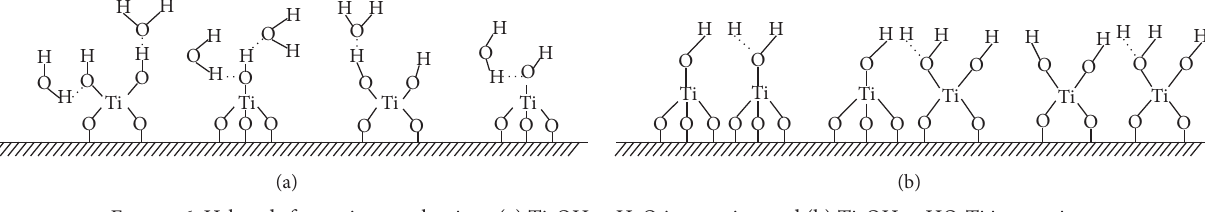
Figure 6: H-bonds formation mechanism: (a) Ti-OH ⋅⋅⋅ H 2 O interaction and (b) Ti-OH ⋅⋅⋅ HO-Ti interaction.